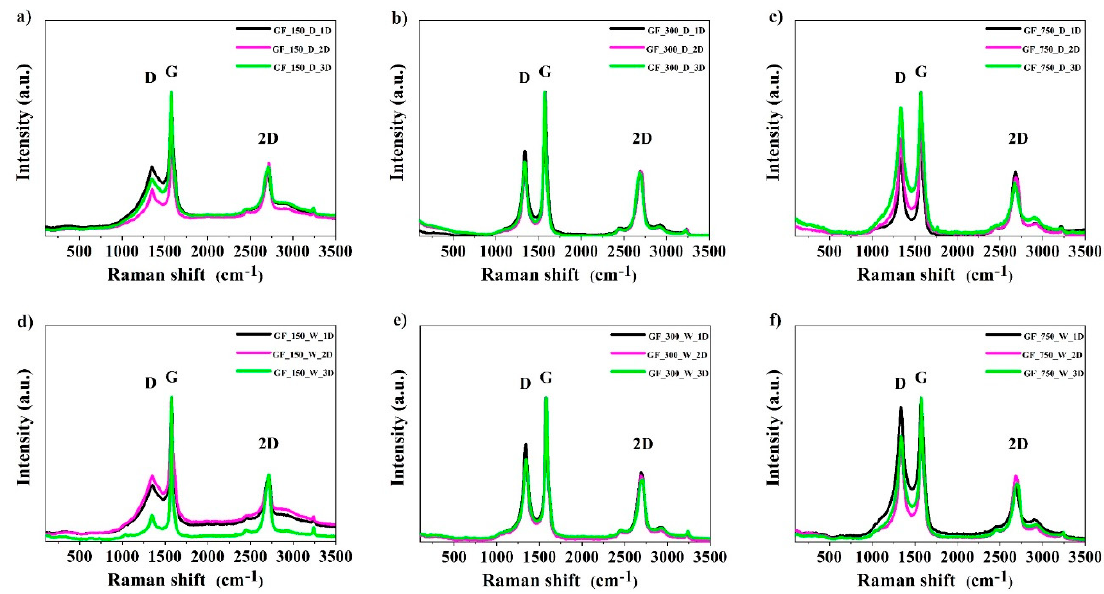
Figure 3. Raman spectra of all investigated series of the obtained samples: ( a ) GF_150_D series, ( b ) GF_300_D series, ( c ) GF_750_D_series, ( d ) GF_150_W series, ( e ) GF_300_W series and ( f ) GF_750_W series.